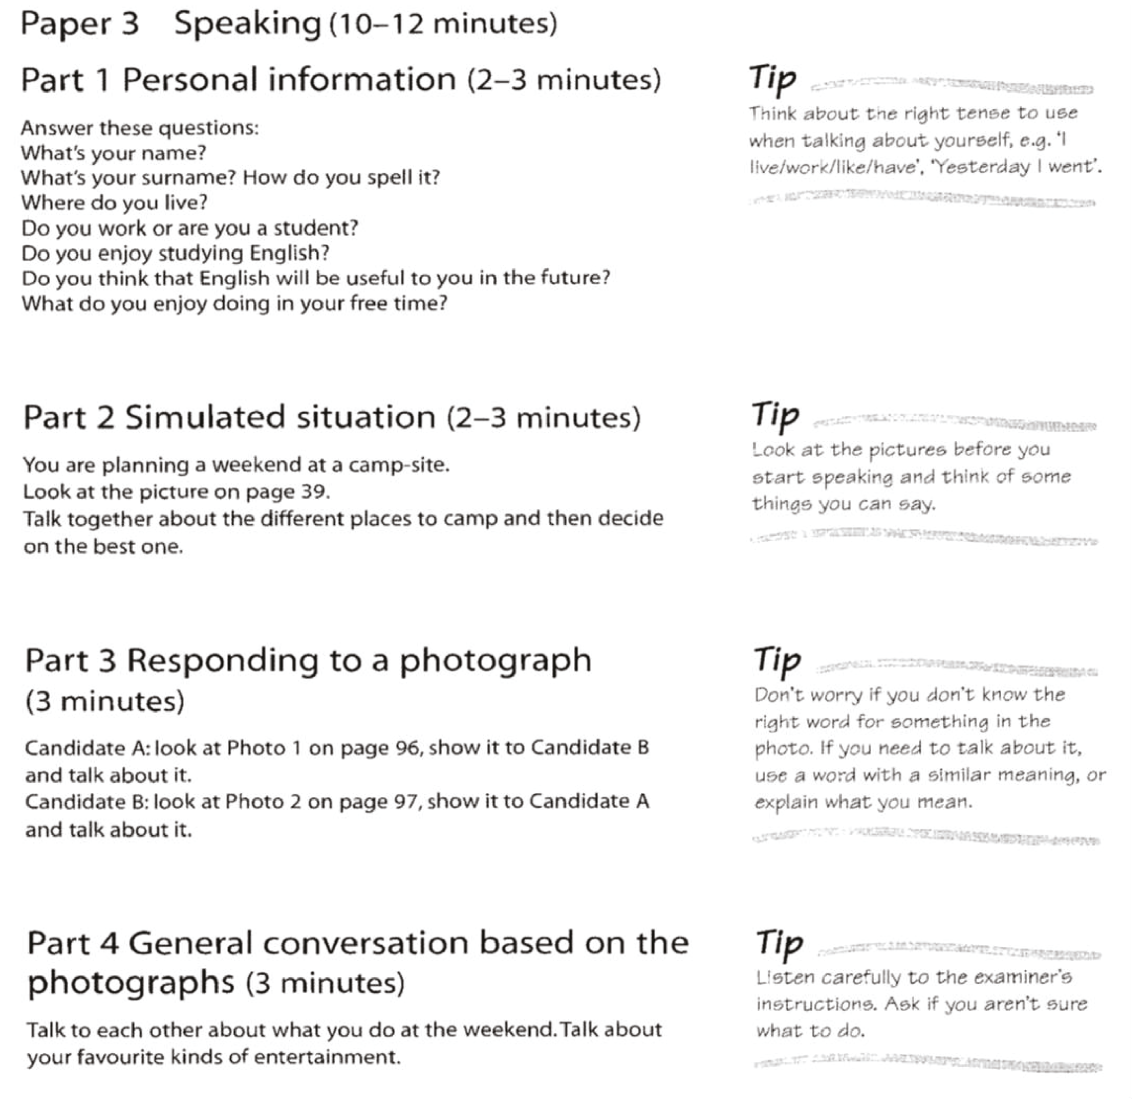
Figure 3: Post-test page